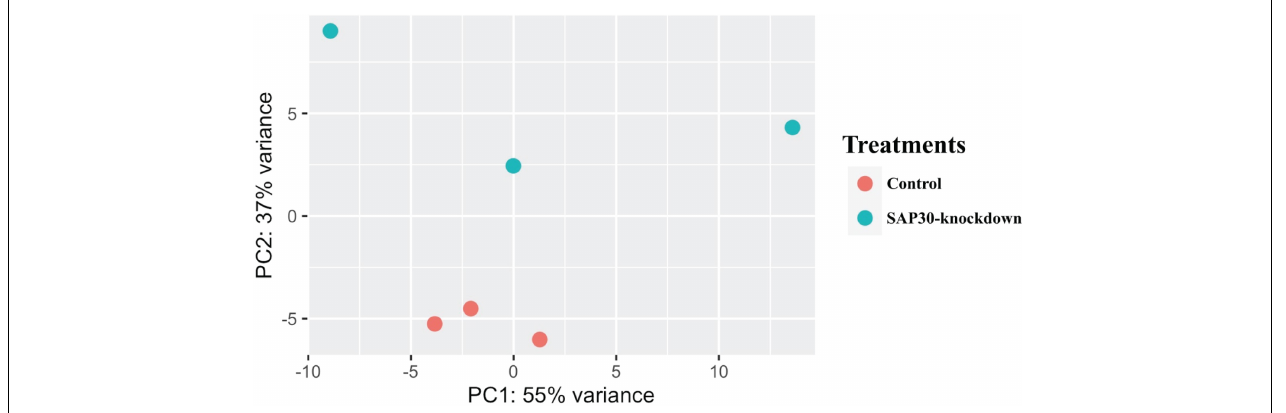
FIGURE 2 | Principal Component Analysis (PCA) clearly showing a variation between genes expressed in the two groups ( SAP30 -knockdown and control) in C2C12 cells. The red dots are representing the triplicates from the control group, while the blue dots are triplicates from SAP30-knockdown group.